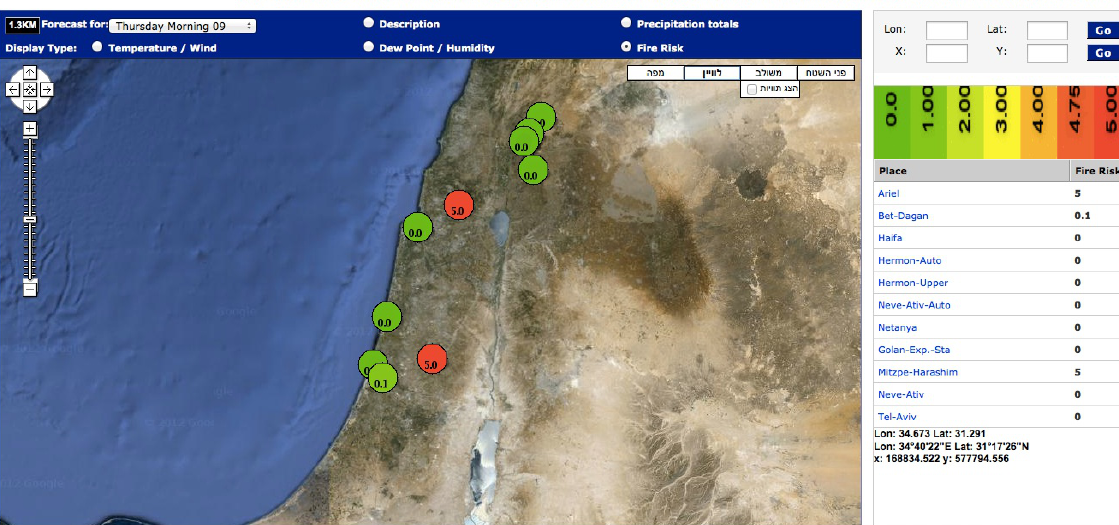
Figure 15. Fire-risk forecast for Israel, computed as the maximal rate of spread in any direction, and rescaled so that the maximum possible Fig. 14. Fire danger forecast, based on the fireline intensity of a potential fire propagating in the direction fire rate of spread from Rothermel’s model corresponds to value of with the maximum rate of spread.